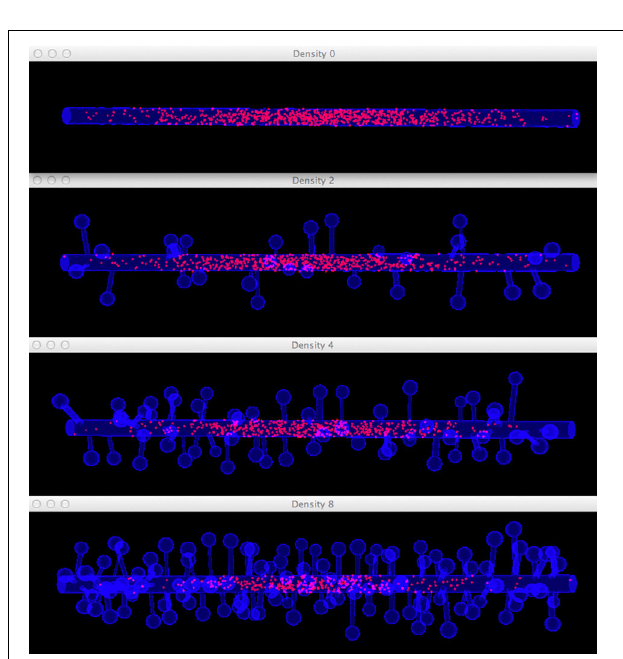
FIGURE 11 | Comparison of diffusion simulations in meshes with different spine densities. As the spine density increases molecules can clearly be seen to diffuse more slowly along the dendritic shaft, indicating the anomalous diffusion effect.